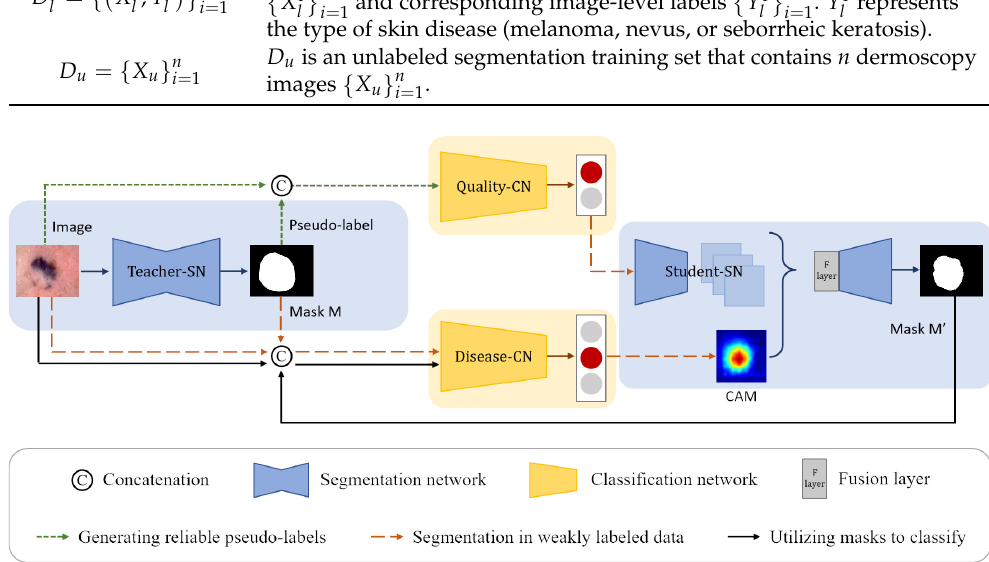
Figure 2. Structure of the CL-DCNN model for skin lesion segmentation and classification. The teacher-SN is constructed to generate the pseudo-labels, which are concatenated with original images as the input to train the quality-CN to screen reliable pseudo-labels for self-training. Then, the masks generated by teacher-SN are employed to provide disease-CN with information about the lesions and promote disease-CN, which can generate accurate CAMs. Following that, we take advantage of CAMs and reliable pseudo-labels to improve the student-SN’s skin lesion segmentation performance. In the end, the masks generated by student-SN are employed to improve the disease-CN’s skin disease identification